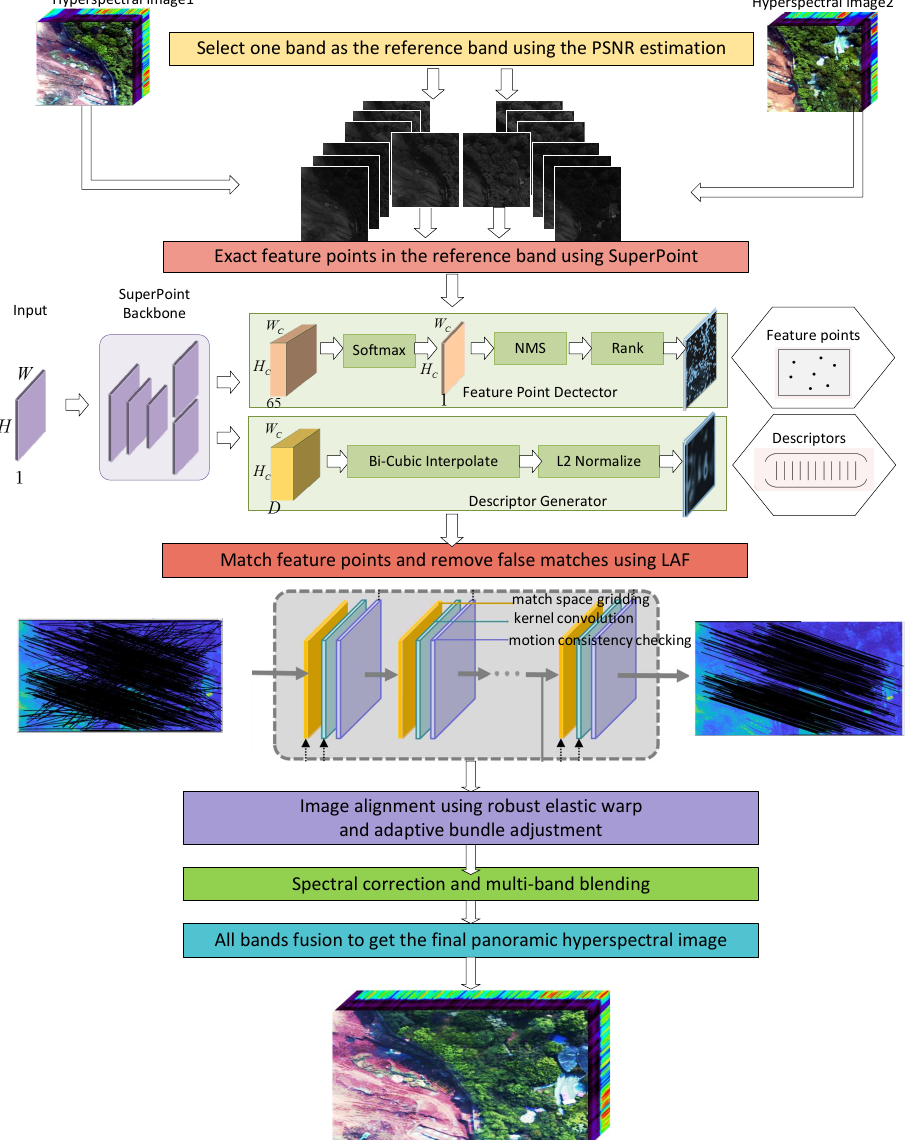
Figure 3. Proposed flow of hyperspectral image